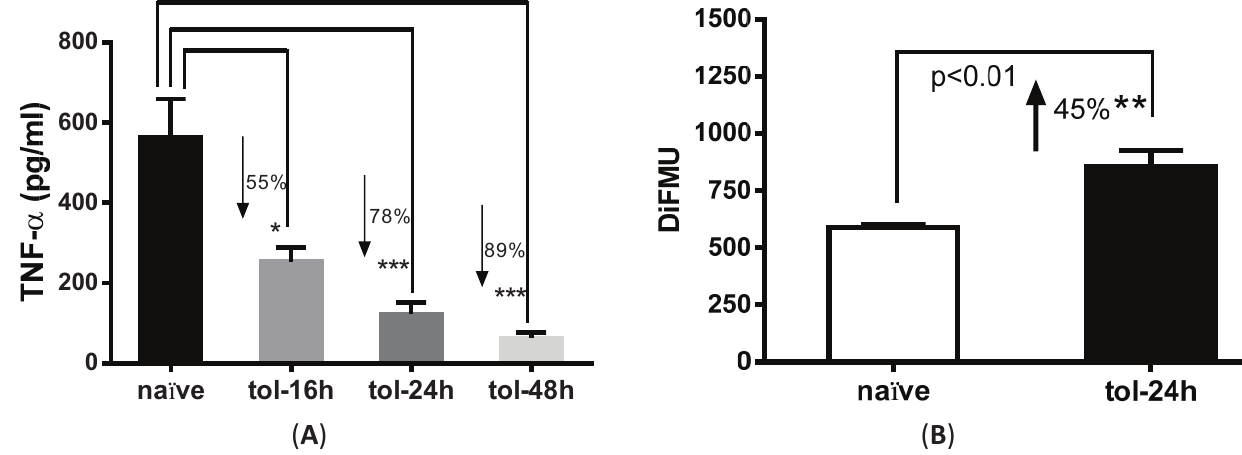
Figure 2. Pre-treatment with LPS induced tolerance and upregulation of phosphatase activity